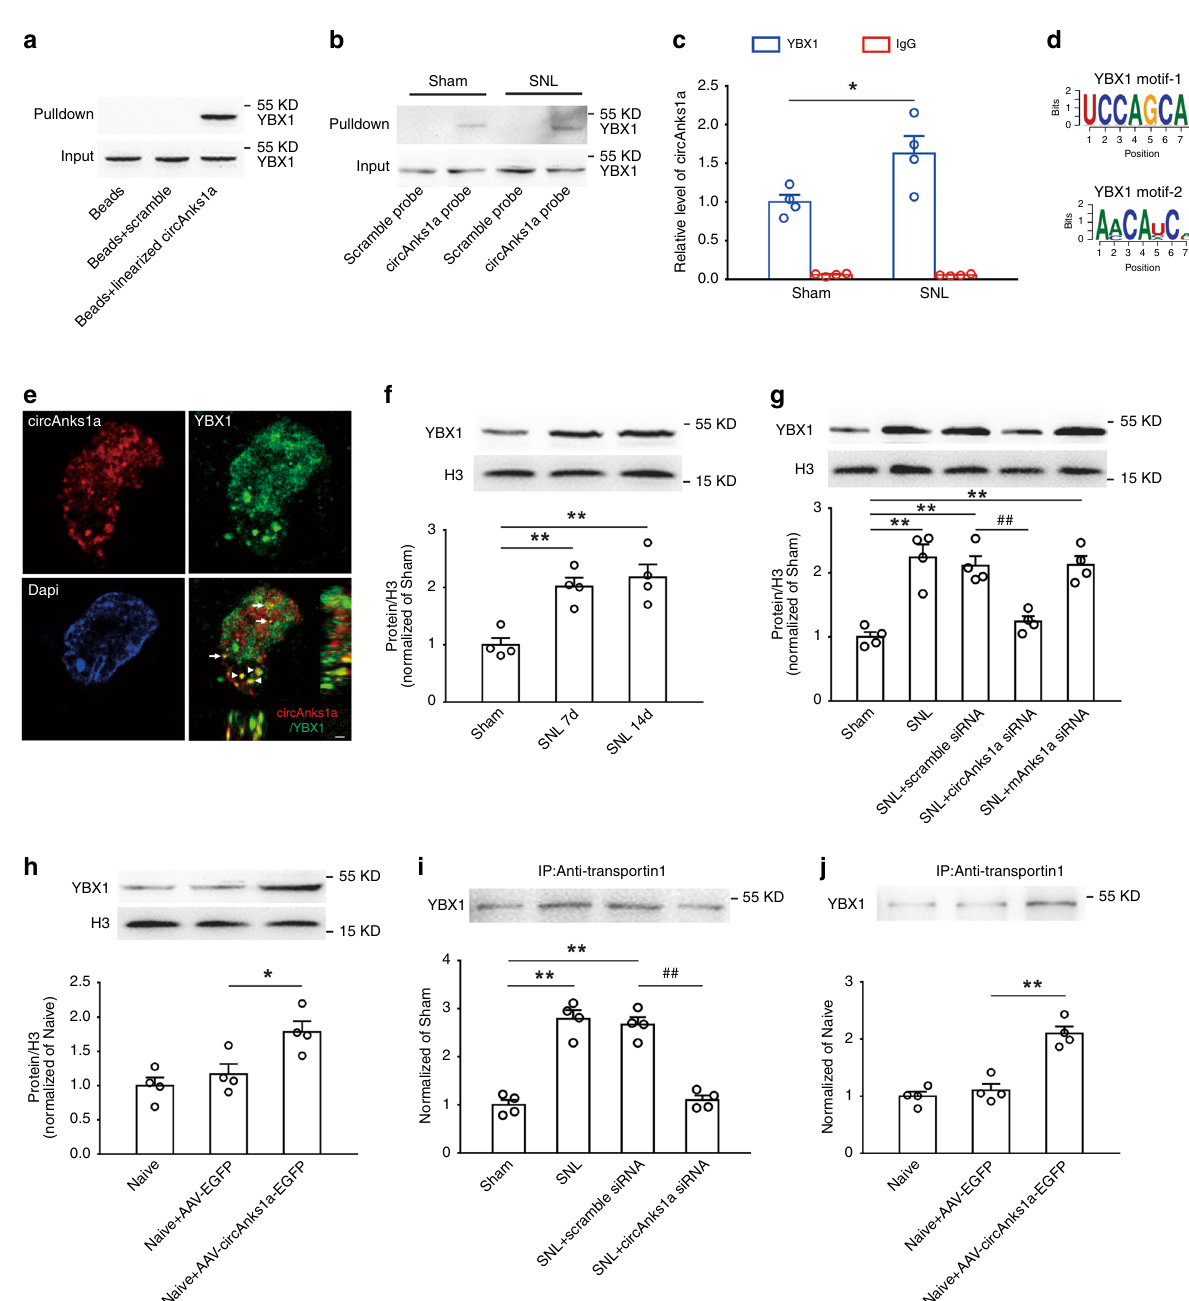
Fig. 6 CircAnks1a promoted the nuclear translocation of YBX1 following SNL. a Exogenous linearized circAnks1a bound to YBX1 on day 14 following SNL ( n = 3). b RNA pulldown assay showed that SNL signi fi cantly increased the interaction of endogenous circAnks1a and YBX1 in the dorsal horn ( n = 3). c The amount of circAnks1a precipitated by YBX1 was obviously increased on day 14 following SNL ( * P < 0.05 vs. the sham group, two-tailed two-sample t tests, n = 4). d Two potential YBX1 motifs were observed in circAnks1a. e High-resolution image showing that binding of circAnks1a to YBX1 occurred in both the nucleus (arrow) and the cytoplasm (arrowhead). Scale bar, 1 μ m ( n = 3). f The level of nuclear YBX1 was signi fi cantly increased on days 7 and 14 after SNL ( ** P < 0.01 vs. the sham group, two-tailed one-way ANOVA, n = 4). g Suppression of circAnks1a by intrathecal injection of circAnks1a siRNA inhibited the increase in nuclear YBX1 on day 14 after SNL ( ** P < 0.01 vs. sham group, ## P < 0.01 vs. corresponding scramble group, two-tailed one-way ANOVA, n = 4). h Overexpression of circAnks1a by intraspinal injection of AAV-circAnks1a-EGFP increased the level of YBX1 in the nucleus ( * P < 0.05 vs. AAV-EGFP group, two-tailed one-way ANOVA, n = 4). i CircAnks1a siRNA signi fi cantly attenuated the increase in YBX1 immunoprecipitation by transportin-1 antibody on day 14 after SNL (** P < 0.01 vs. sham group, ## P < 0.01 vs. corresponding scramble group, two-tailed one-way ANOVA, n = 4). j Intraspinal injection of AAV-circAnks1a-EGFP increased the amount of YBX1 in the immunocomplex precipitated by transportin-1 ( ** P < 0.01 vs. the AAV- EGFP group, two-tailed one-way ANOVA, n = 4). The data are presented as the mean ± s.e.m. Source data are available as a Source Data fi le